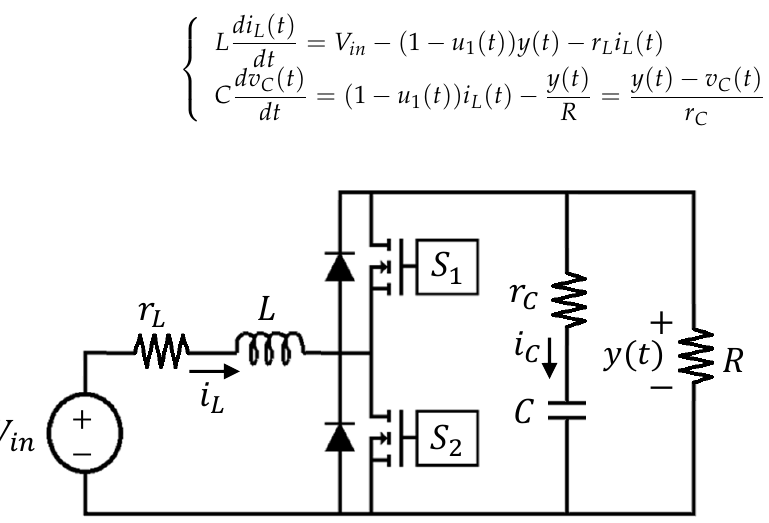
Figure 1. Boost Converter circuit diagram: u 1 = 1 when S 1 = 1, S 2 = 0 and u 1 = 0 when S 1 = 0, S 2 =